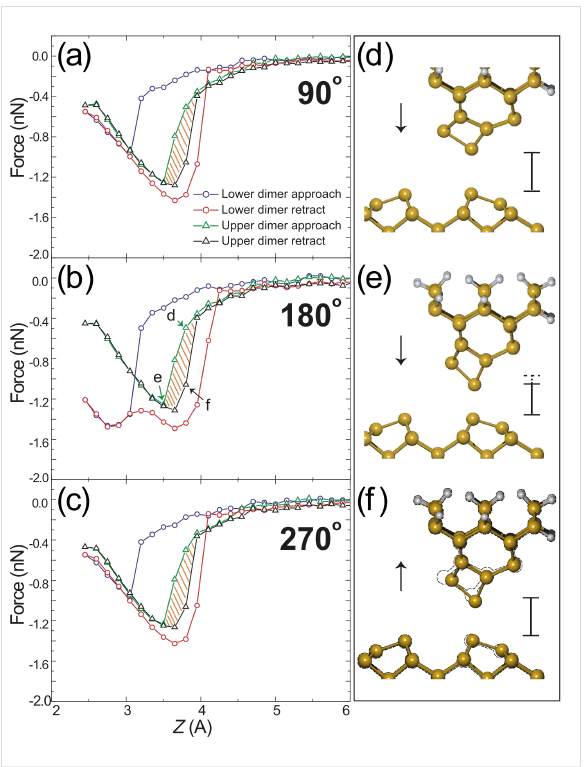
clear indicator of the successful switching event. Figure 2a depicts spectra that were taken with the high-stability H3 struc- which shows no variation upon rotation.